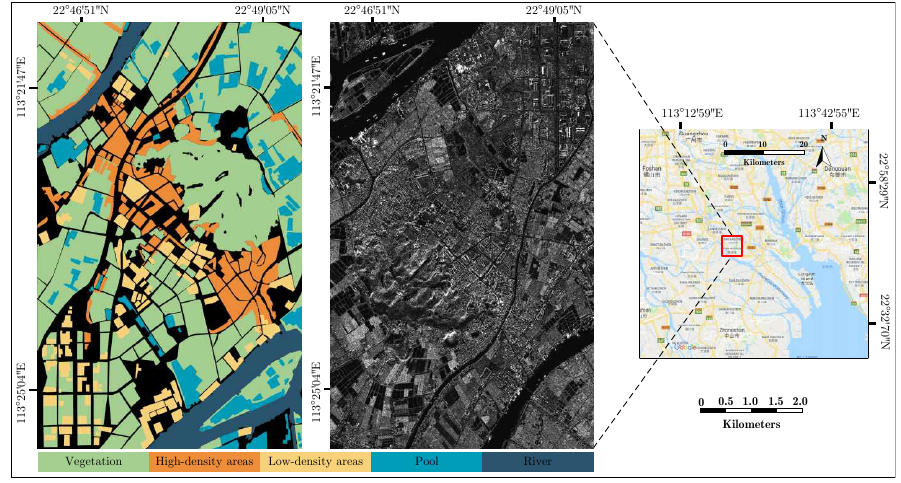
Figure 7. Overview of the Guangdong data. The unidentifiable class is shown in black in the ground truth image.